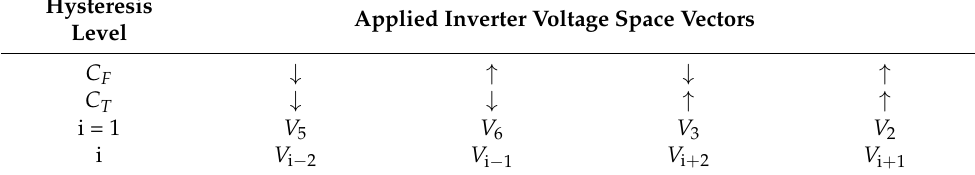
Table 1. Conventional switching table of the DTC algorithm. Hysteresis Applied Inverter Voltage Space Level